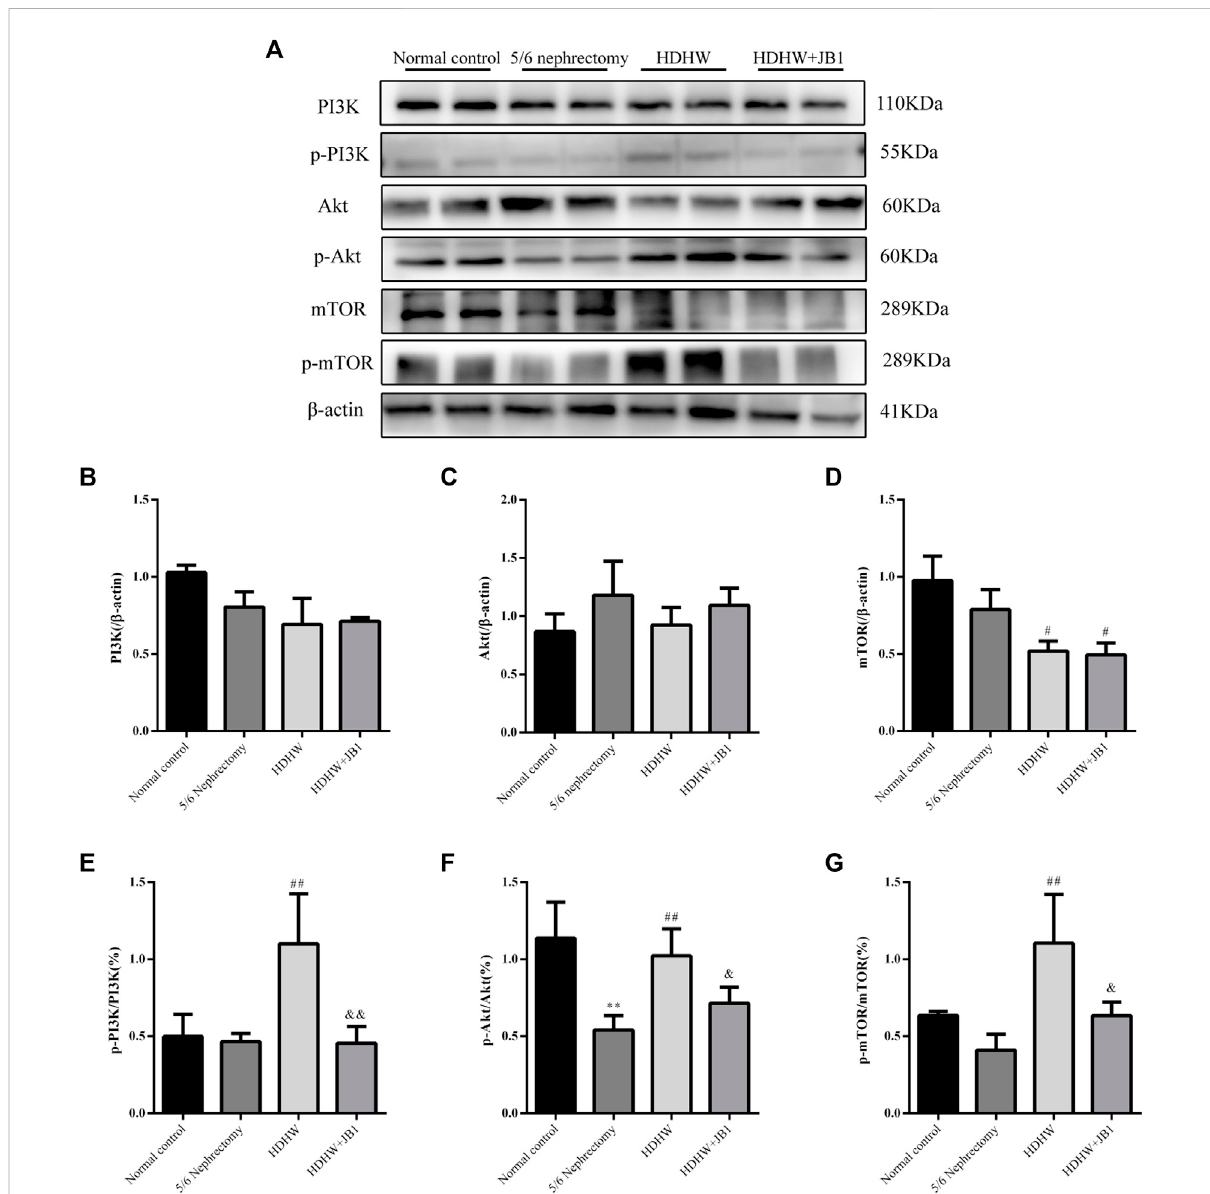
FIGURE 7 HeidihuangWan (HDHW) exerts nephroprotective effects by regulating the IGF-1-mediated PI3K/Akt/mTOR pathway. (A) Western Blotting for proteinlevels ofPI3K, p-PI3K, Akt, p-Akt, mTOR,p-mTOR. (B,C,D,E,F,G) Proteinconcentrationanalysis.Data arepresented asmean± SD, n =3.The data are expressed as ** p < 0.01: compared with normal control group; # p < 0.05, ## p < 0.01: compared with 5/6 nephrectomy group; & p < 0.05, && p < 0.01: compared with HDHW group,